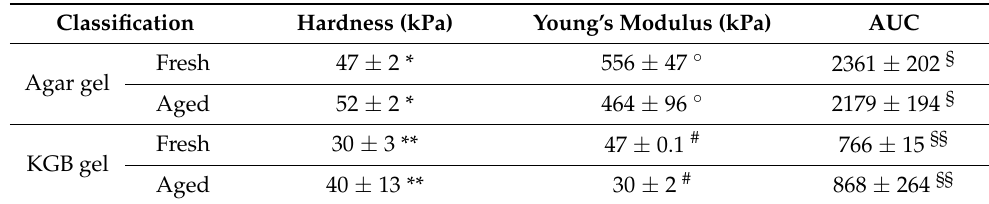
Table 2. Mechanical properties of gels determined by tensile testing (mean value ± s.d.; n = 3). ANOVA one-way ( p < 0.05), Multiple Range Test: different symbols indicate statistically different data. AUC: Area Under the stress–strain curve.